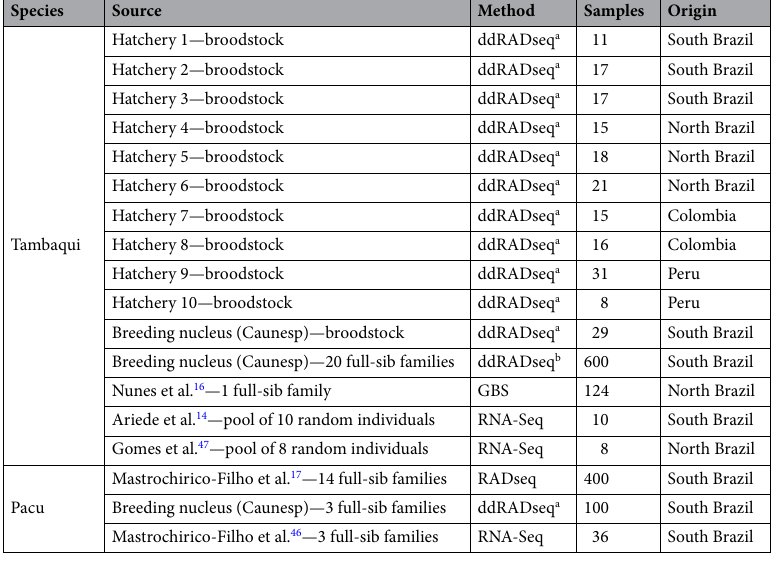
Table 6. Details about the sampling and methods used for SNP discovery for each species. a Enzyme combination I (SphI and MluCI). b 3 families used the enzyme combination I (SphI and MluCI) and 17 families used the combination II (NlaIII and